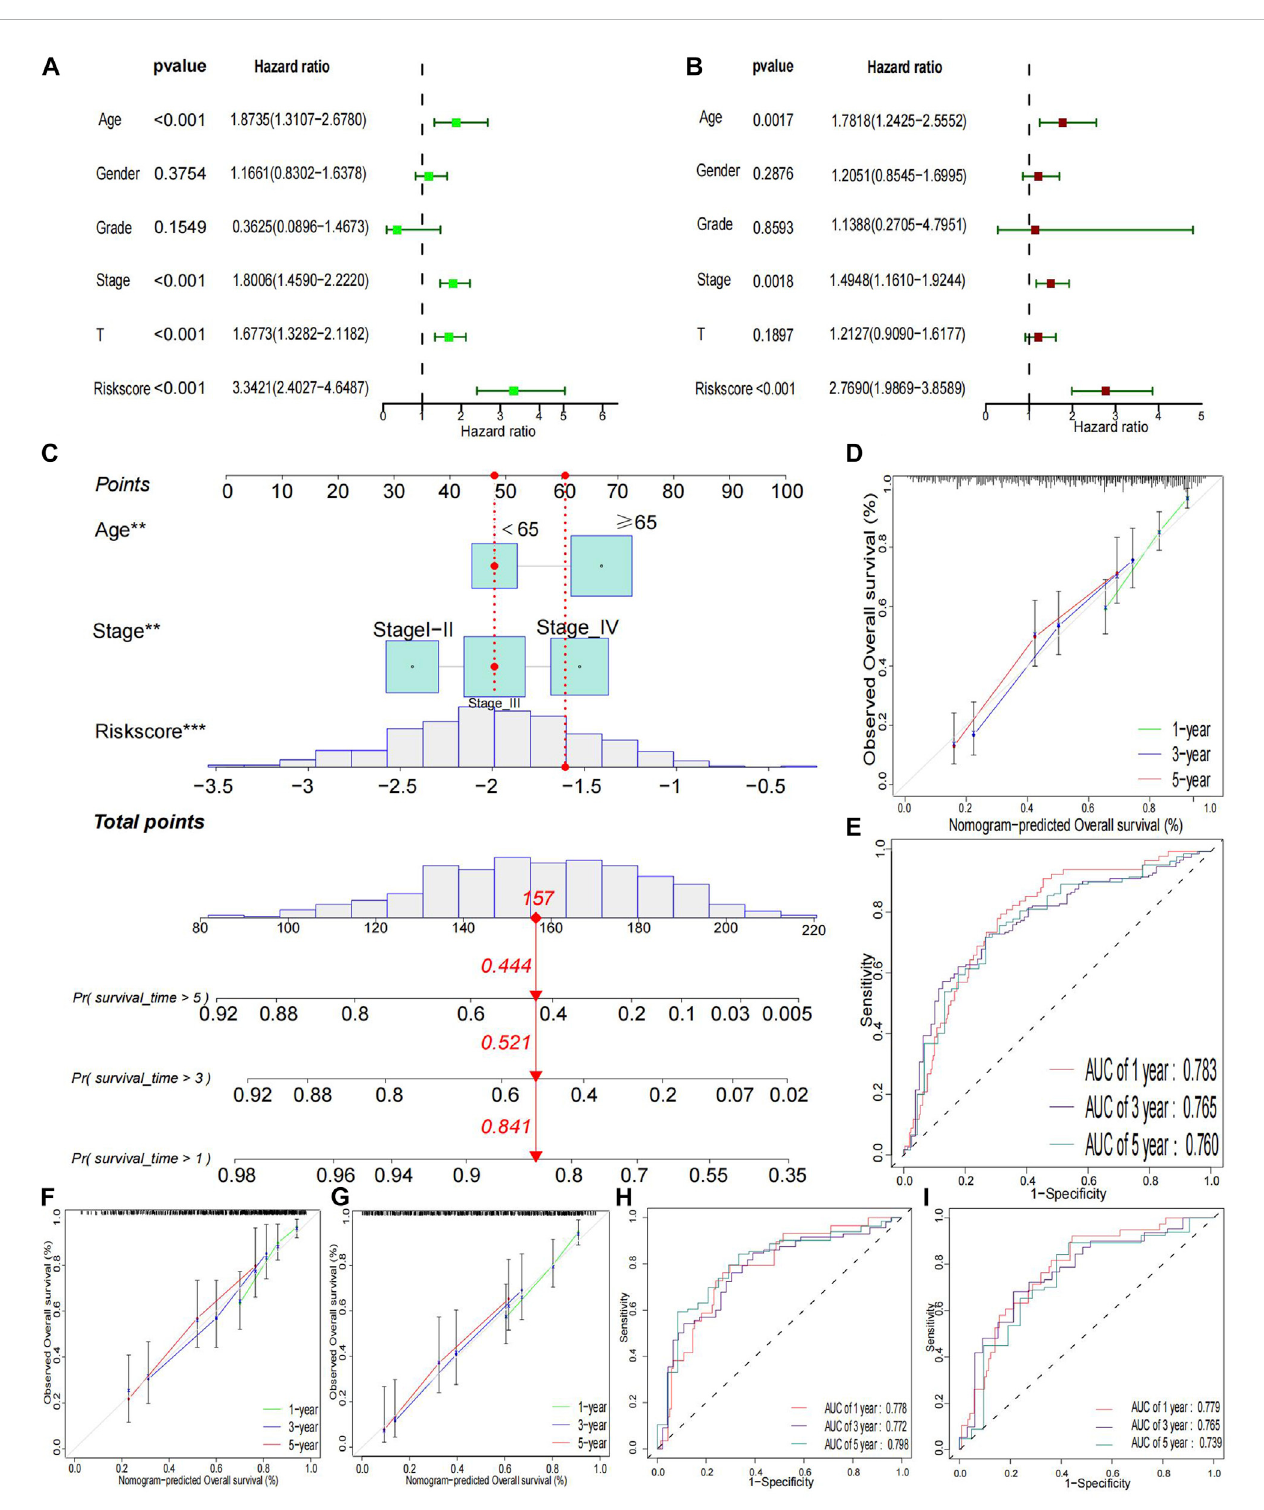
FIGURE 4 Clinical relevance Analysis and Validation (A) Univariate prognostic analysis. (B) Multivariate prognostic analysis. (C) Constructed a nomogram in whole groups. (D, E) Calibration curves and ROC for 1-, 3-, and 5 year in the entire group. (F – I) Calibration curves and ROC for 1-, 3-, and 5-year in training and testing groups,